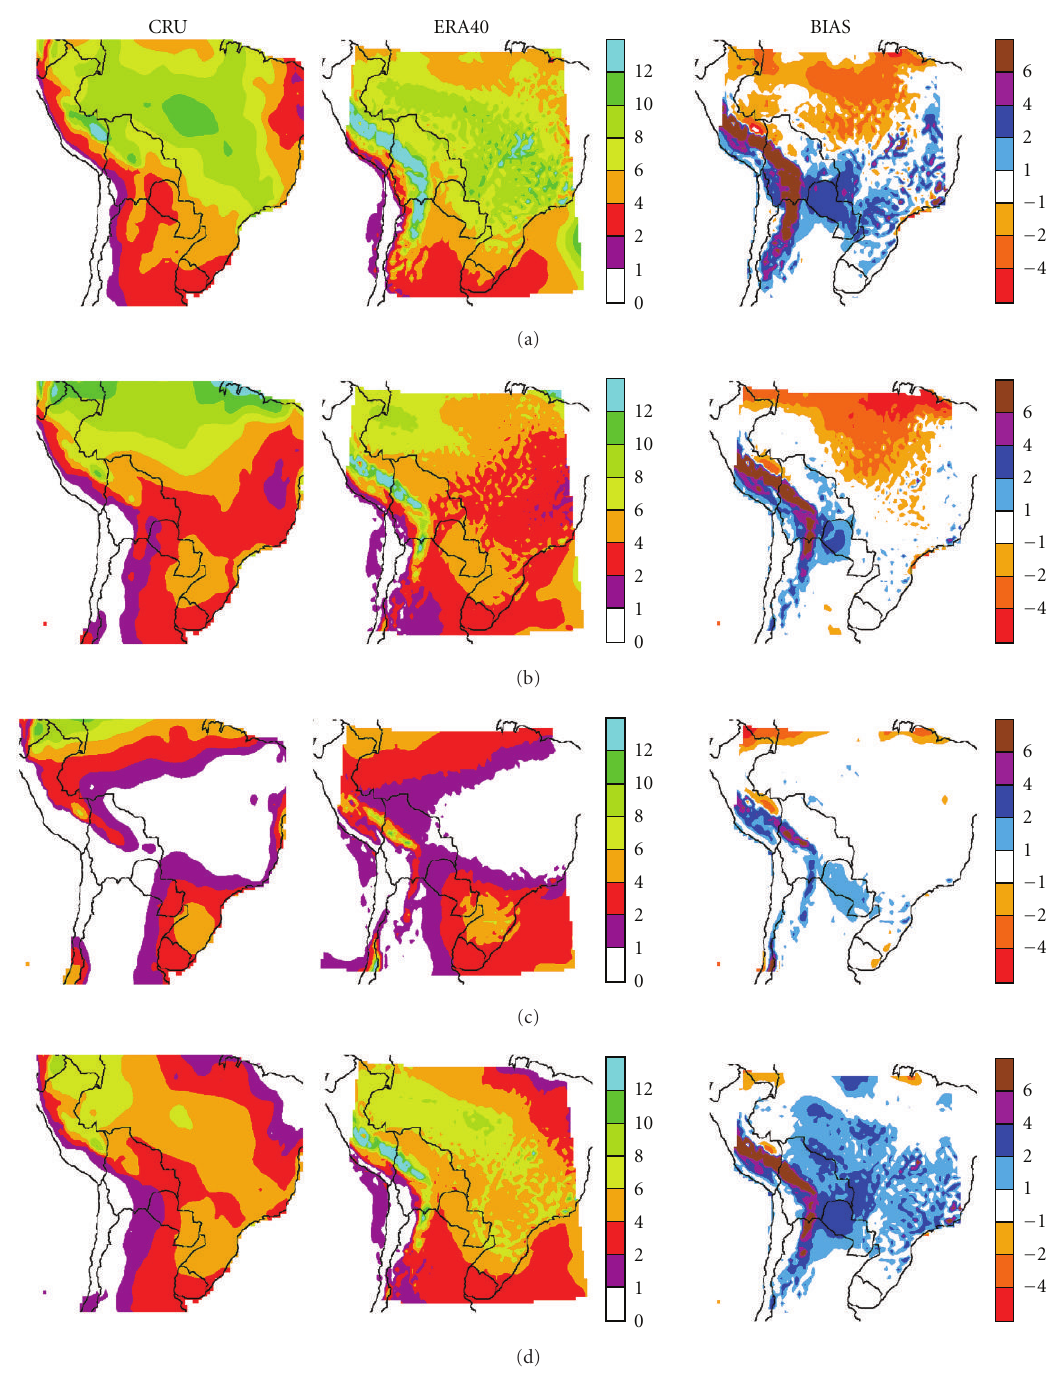
Figure 5: Same as Figure 4, comparing in this case CRU with CONTROL-E40 precipitation rate.